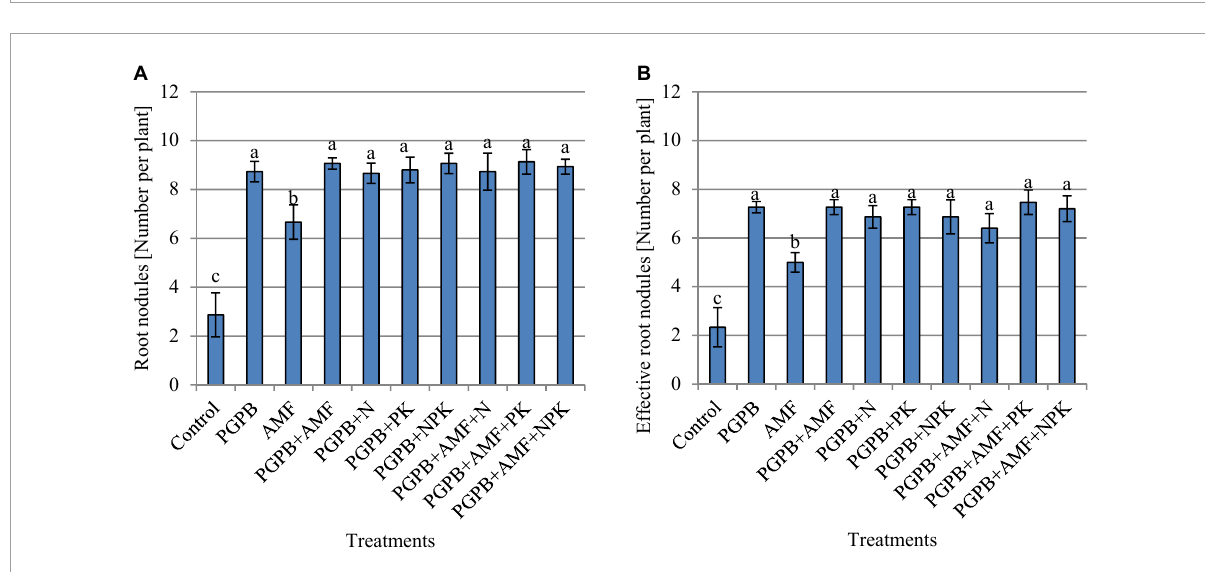
FIGURE4 The total number of root nodules per plant (A) and the number of effective root nodules per plant (B) as affected by inoculation of plant growth-promoting bacteria (PGPB) and arbuscular mycorrhiza fungi (AMF), with or without the addition of nitrogen (N), phosphorus (P), and potassium (K) fertilizers. Data (Mean ± SD) with different letters are significantly different (Tukey’s HSD, p < 0.001).